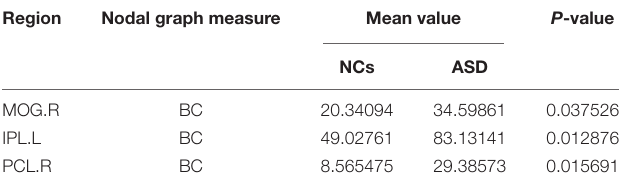
TABLE 4 | Between-group comparison in BC. Region Nodal graph measure Mean value